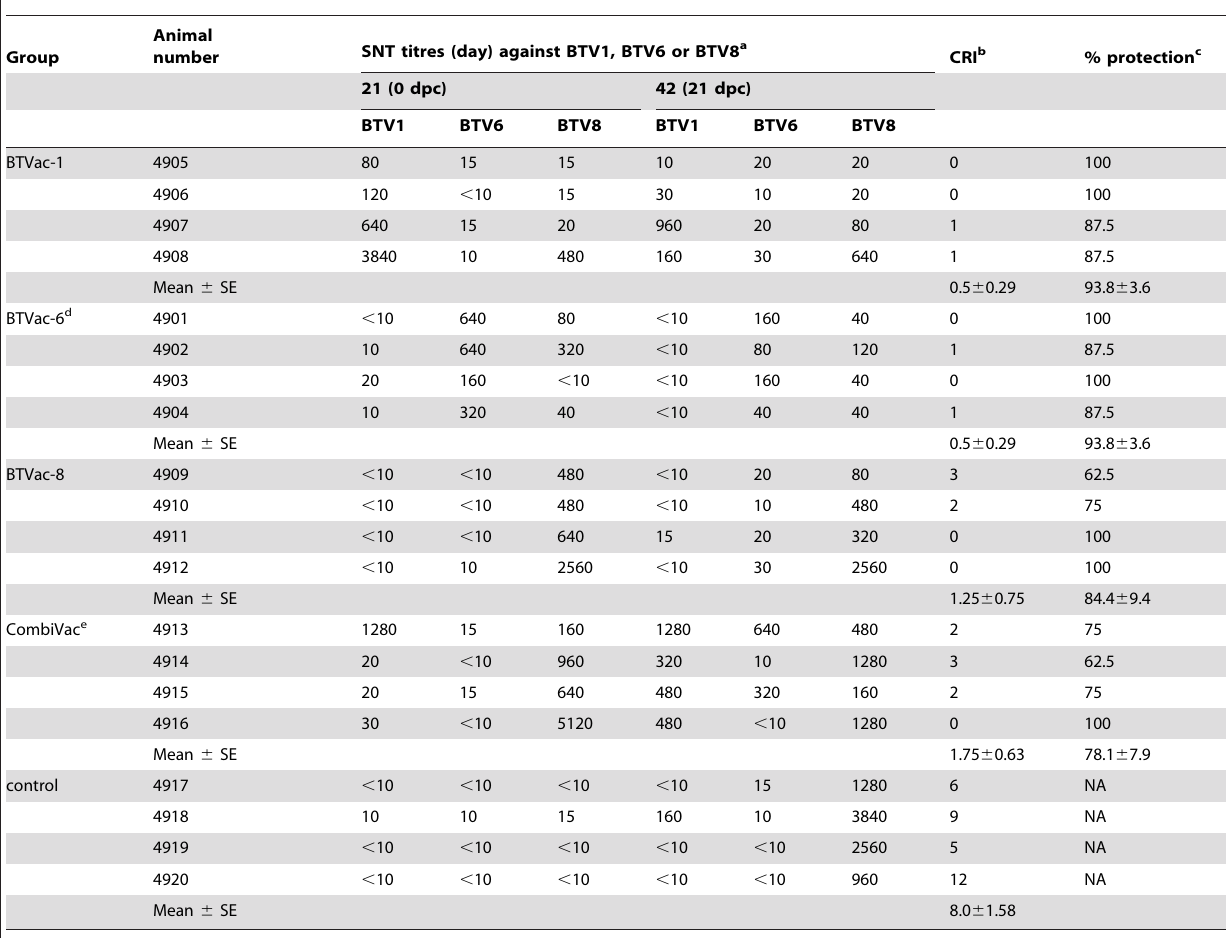
Table 3. nAb titres by serum neutralizing tests (SNTs), clinical reaction indexes (CRIs) and the percentage of protection.